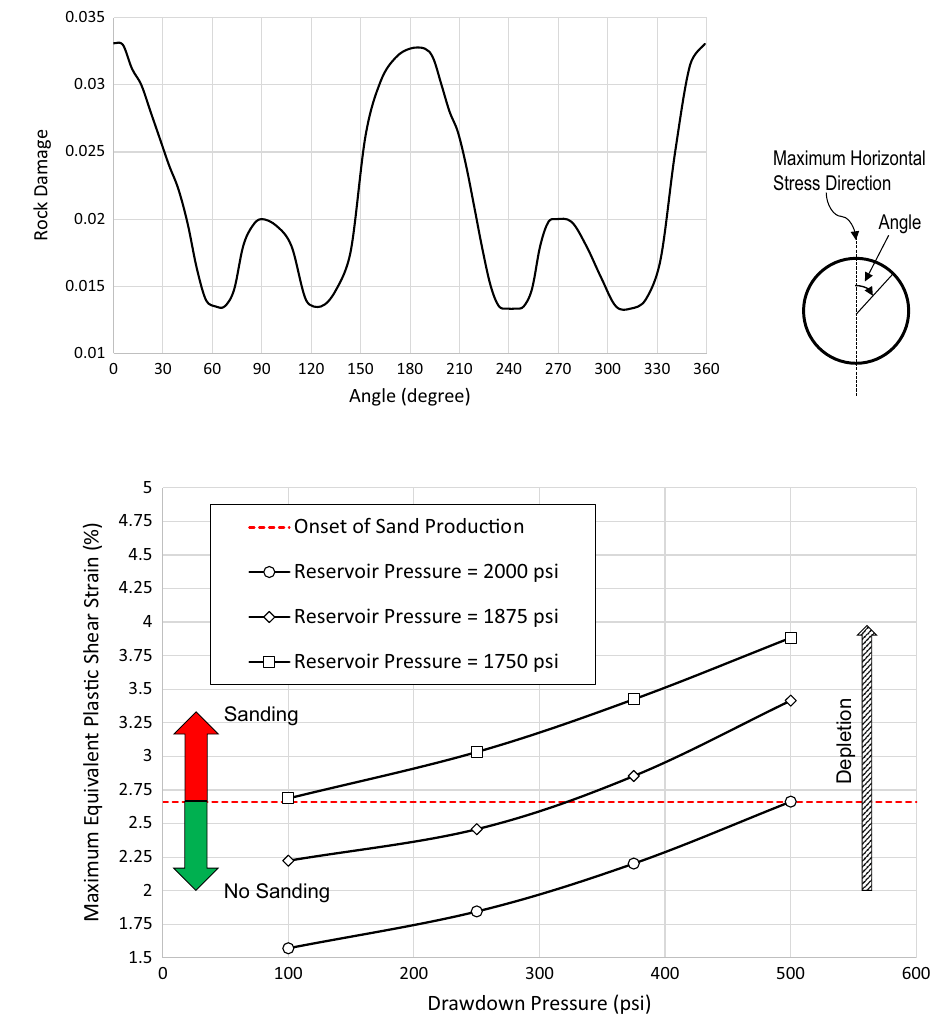
Table 2 Critical drawdown pressure corresponding to onset of sand production for different reservoir pressures